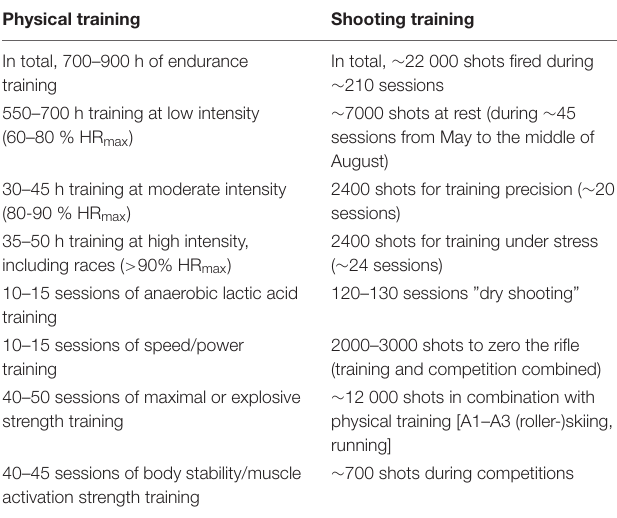
TABLE 2 | Overview of training by the successful Swedish biathletes who won medals at the Pyeongchang Olympic Games in 2018. Physical